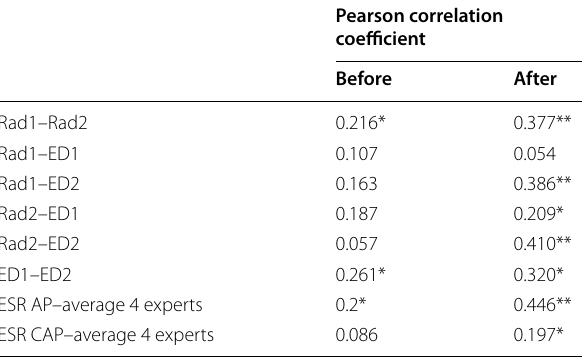
Table 2 Correlation between pairs of physicians’ ratings, and between ESR score (two protocols: abdomen–pelvis, chest– abdomen–pelvis) and average physician rate before and after consulting the ESR